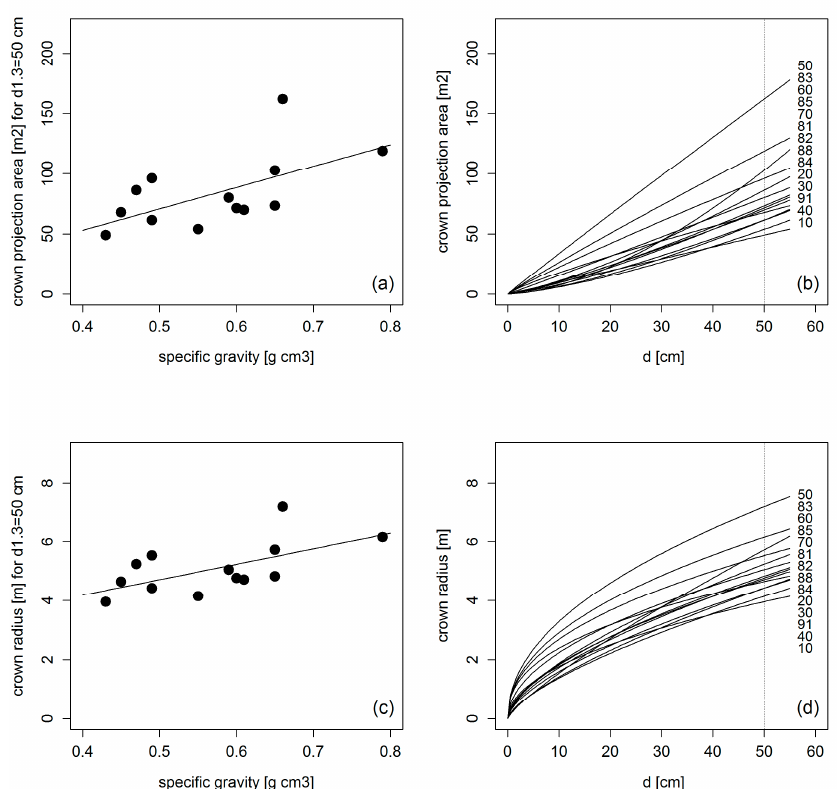
Figure 10. Relationship between dry wood density R and the crown extension of primary forest tree species. ( a ) cpa of trees of 50 cm stem diameter depending on R, ( b ) crown projection area cpa depending on stem diameter, ( c ) crown radius of trees of 50 cm stem diameter plotted over wood density R, ( d ) crown radius cr depending on stem diameter. The vertical line indicates stem diameter 50 cm and the cr values used for (c). (see model 4 in Table 1 for (a) and (c) and model 5 in Supplementary Table S1 for (b) and (d)).